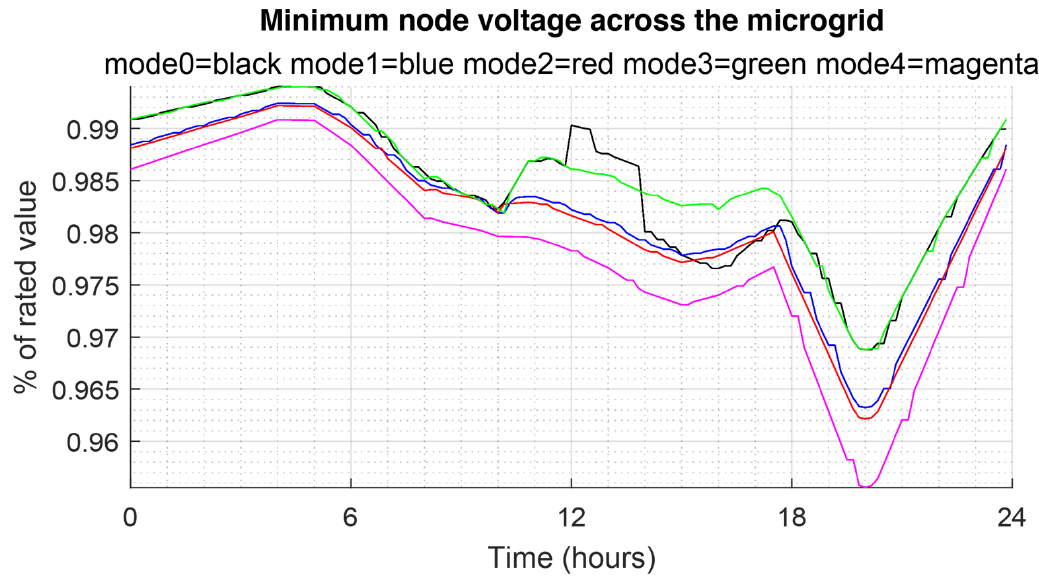
Figure 9. Minimum node voltage measured across the entire microgrid for the various control methods.